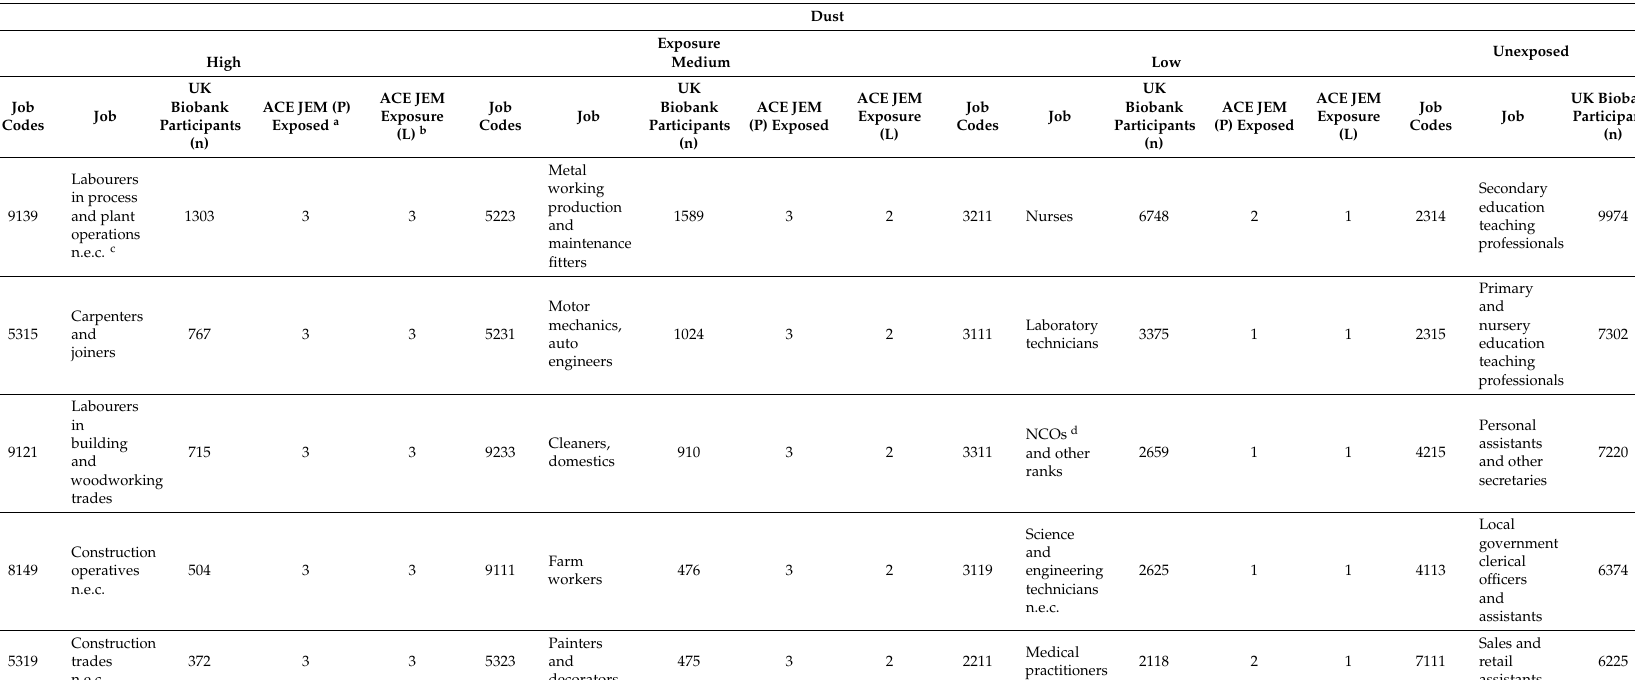
475 2211 Medical practitioners 2118 7111